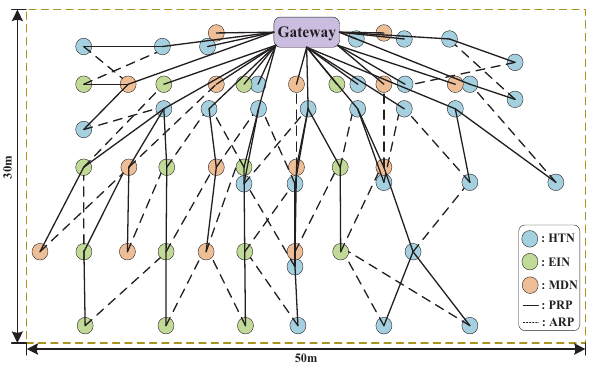
Figure 11. Experiment topology.